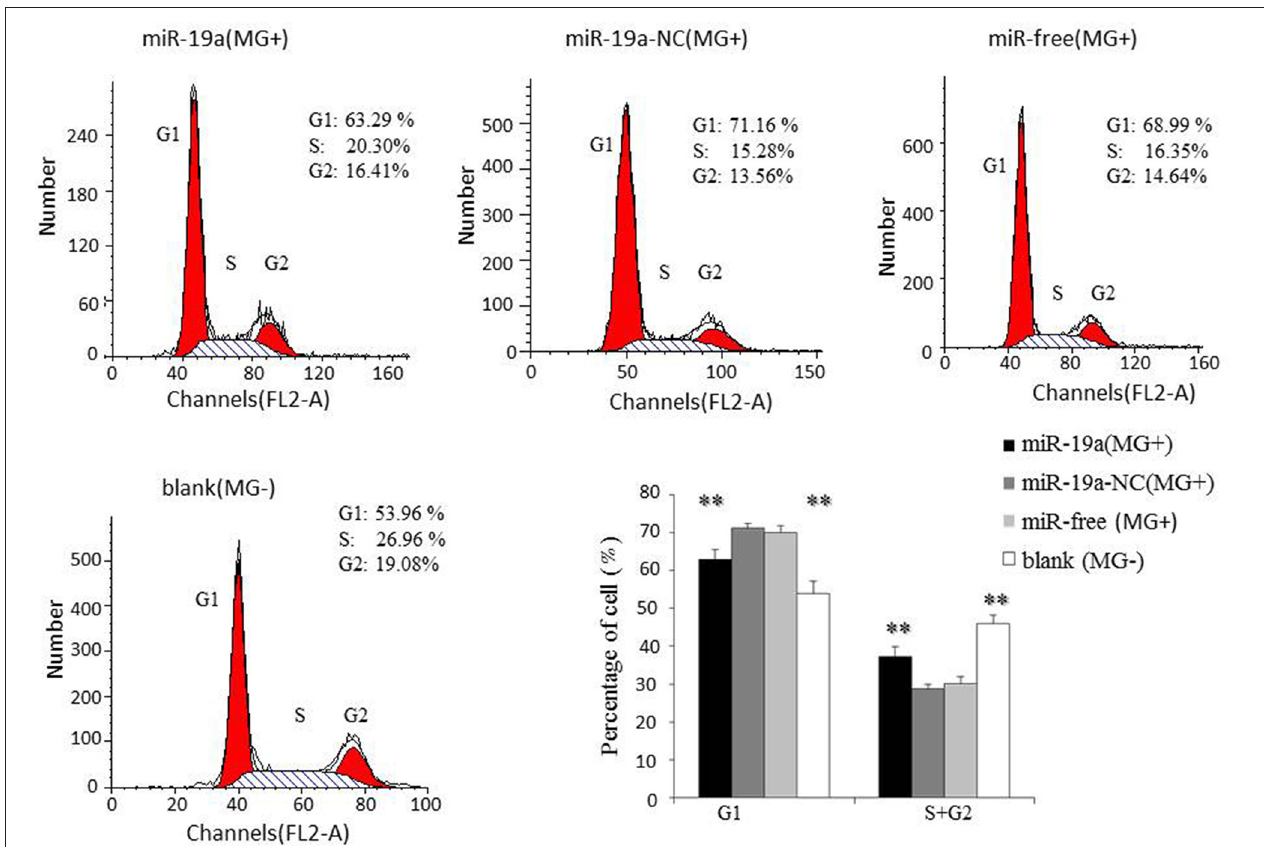
FIGURE 6 | The effect of the over-expression of gga-miR-19a on the distribution of DF-1 cells in the cell cycle. DF-1 cells were transfected with gga-miR-19a or miR-19a-NC and were incubated for 4 h. The cells then were infected with MG-HS strain. Three control groups, including miR-19a-NC (MG + ), miR-free (MG + ) and blank (MG − ), were used. At 48 h post-transfection, the cell phase distribution was analyzed using a flow cytometer. Three independent experiments were performed in triplicate. All values are represented as the mean ± SD. Significant differences are denoted as ** P <